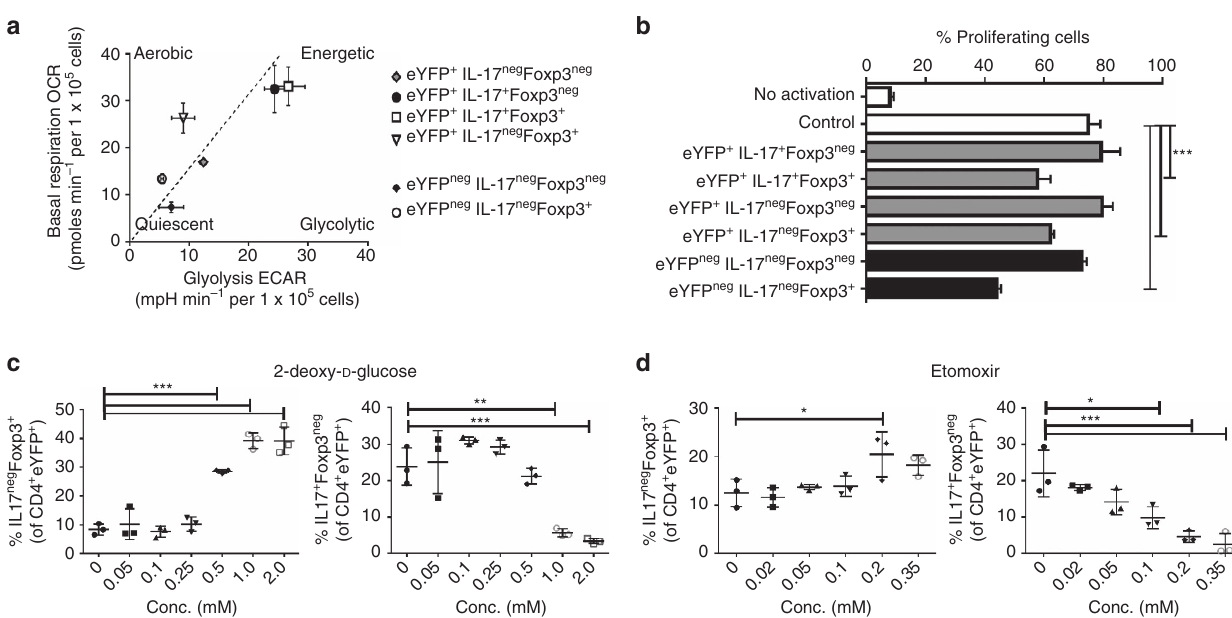
Figure 5 | Suppressive Foxp3 þ IL-17A þ cells are metabolically active. ( a , b ) YFP þ Foxp3 neg IL-17A þ , YFP þ Foxp3 þ IL-17A þ , YFP þ Foxp3 neg IL-17A neg , YFP þ Foxp3 þ IL-17A neg and YFP neg Foxp3 neg IL-17A neg , YFP þ Foxp3 neg IL-17A neg CD3 þ T cells were sorted using the strategy presented in Fig. 4e and analysed with XFe Extracellular Flux Analyzer. ( a ) Cumulative data of two independent experiments evaluating basal respiration (OCR) versus glycolysis (basal extracellular acidification rate (ECAR)) of individual Th17–T reg subsets (mean values of each real-time run, n ¼ 2 for YFP þ IL-17A þ Foxp3 neg , YFP þ IL-17A þ Foxp3 þ , YFP þ IL-17A neg Foxp3 neg , YFP þ IL-17A neg Foxp3 þ and YFP neg IL-17A neg Foxp3 þ , n ¼ 7 YFP neg IL-17A neg Foxp3 neg ). ( b ) CD4 þ Tcells, isolated from Cd45.1 mice and stained with CFSE, were analysed after 72h of stimulation with a CD3 Ab, in the presence of irradiated CD4 neg fraction and Th17–T reg subsets, sorted as presented in Fig. 4e. One-way analysis of variance (ANOVA) of immunosuppressive effects of the subsets at 1:4 ratio subset:CD4 þ . Similar results were obtained in an additional independent experiment. ( c , d ) The dose-dependent effects of 2DG ( c ) and etomoxir ( d ) on the transdifferentiation of Th17 cells (the percentage of IL-17A neg Foxp3 þ cells of CD4 þ eYFP þ ) is shown. Similar results were obtained in an